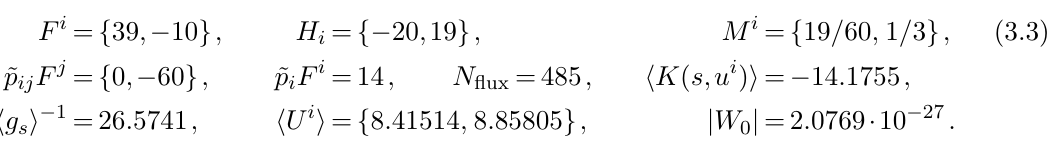
the lowest value of | W